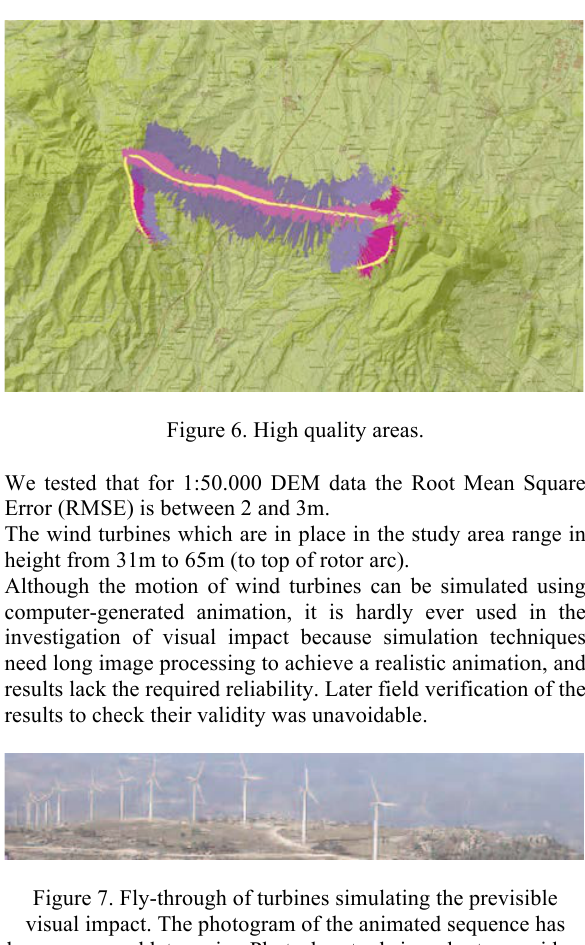
Table 4. Error parameters in DEMs.